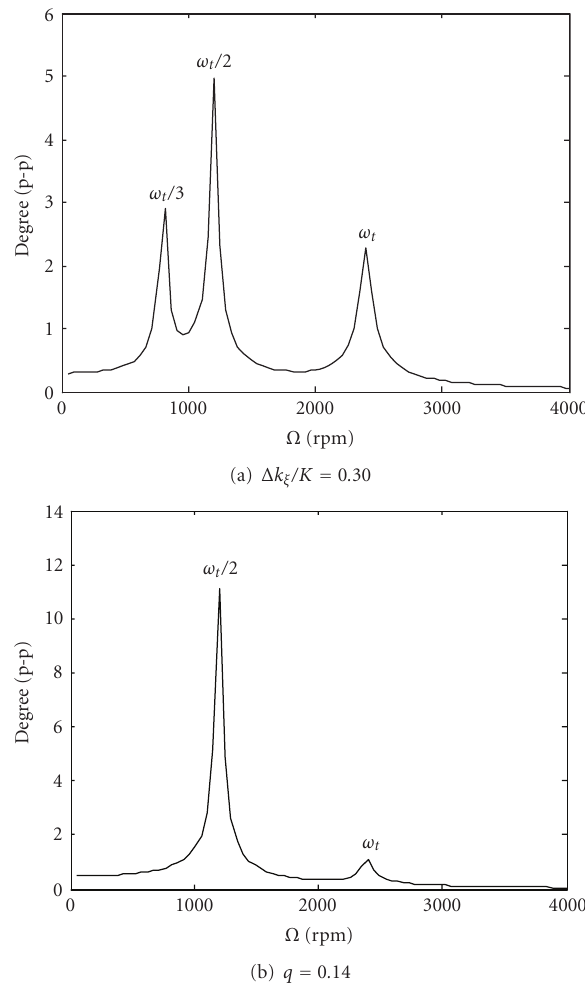
Figure 3: Overall peak-to-peak torsional vibration response, ϕ , spe- cial cases, for cracked shaft (a) and asymmetric shaft